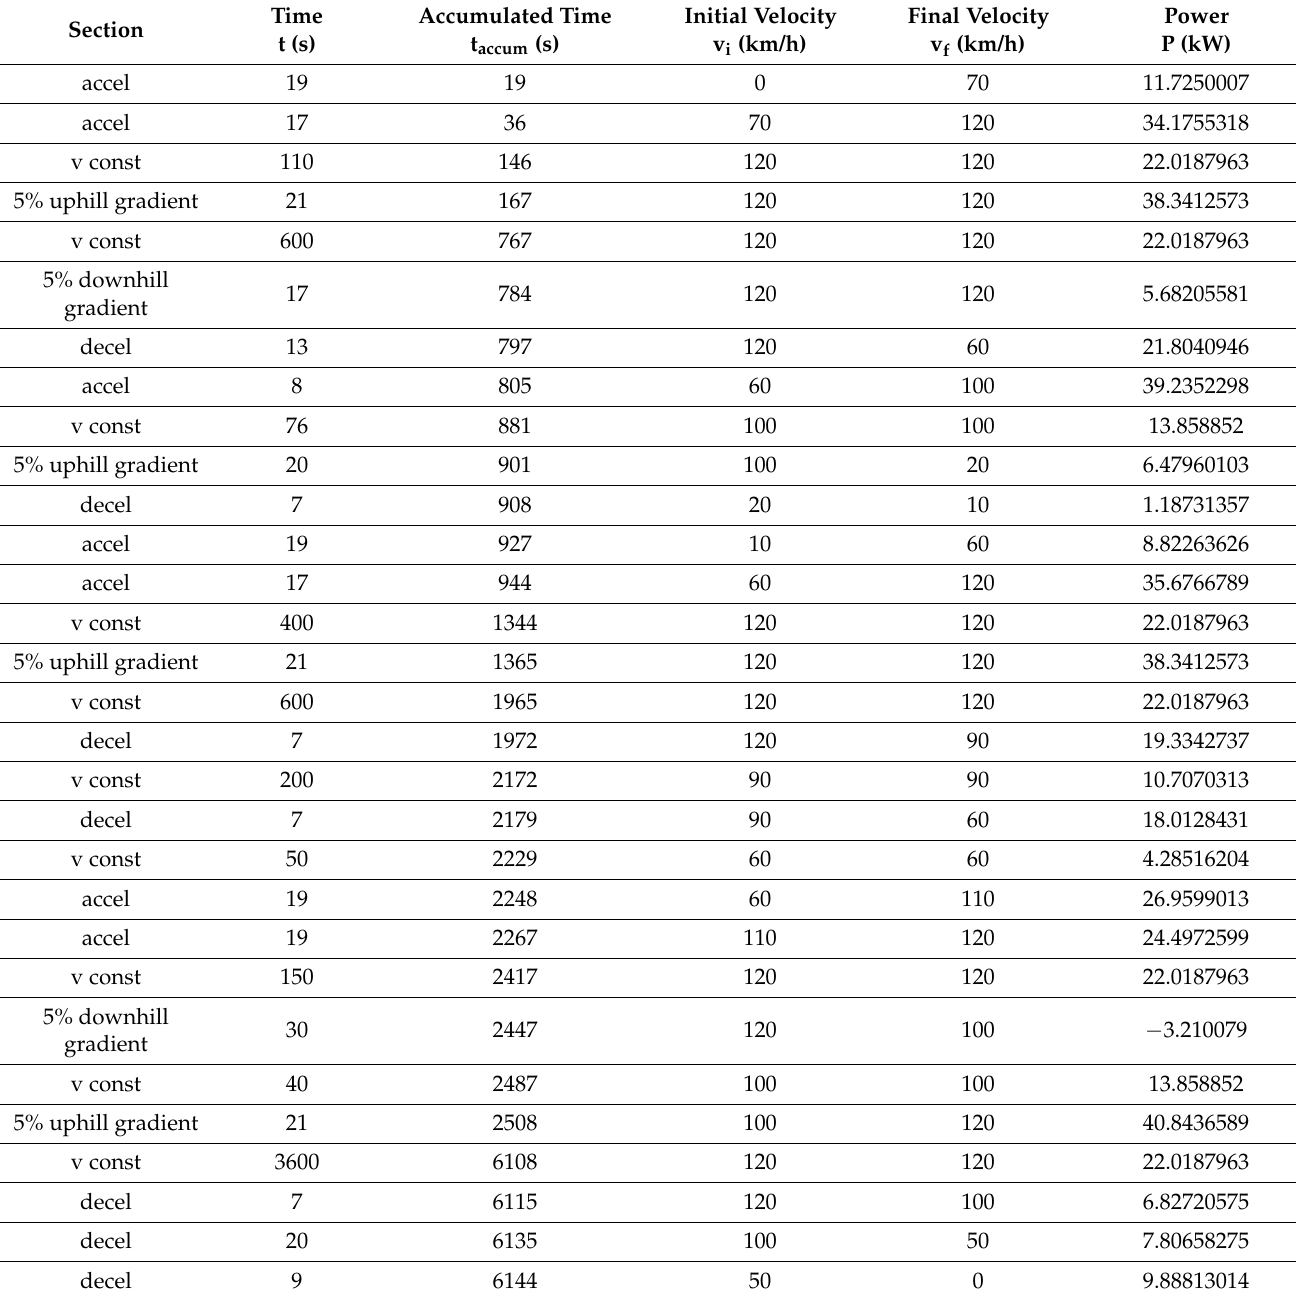
Table 3. Driving characteristics for scenario